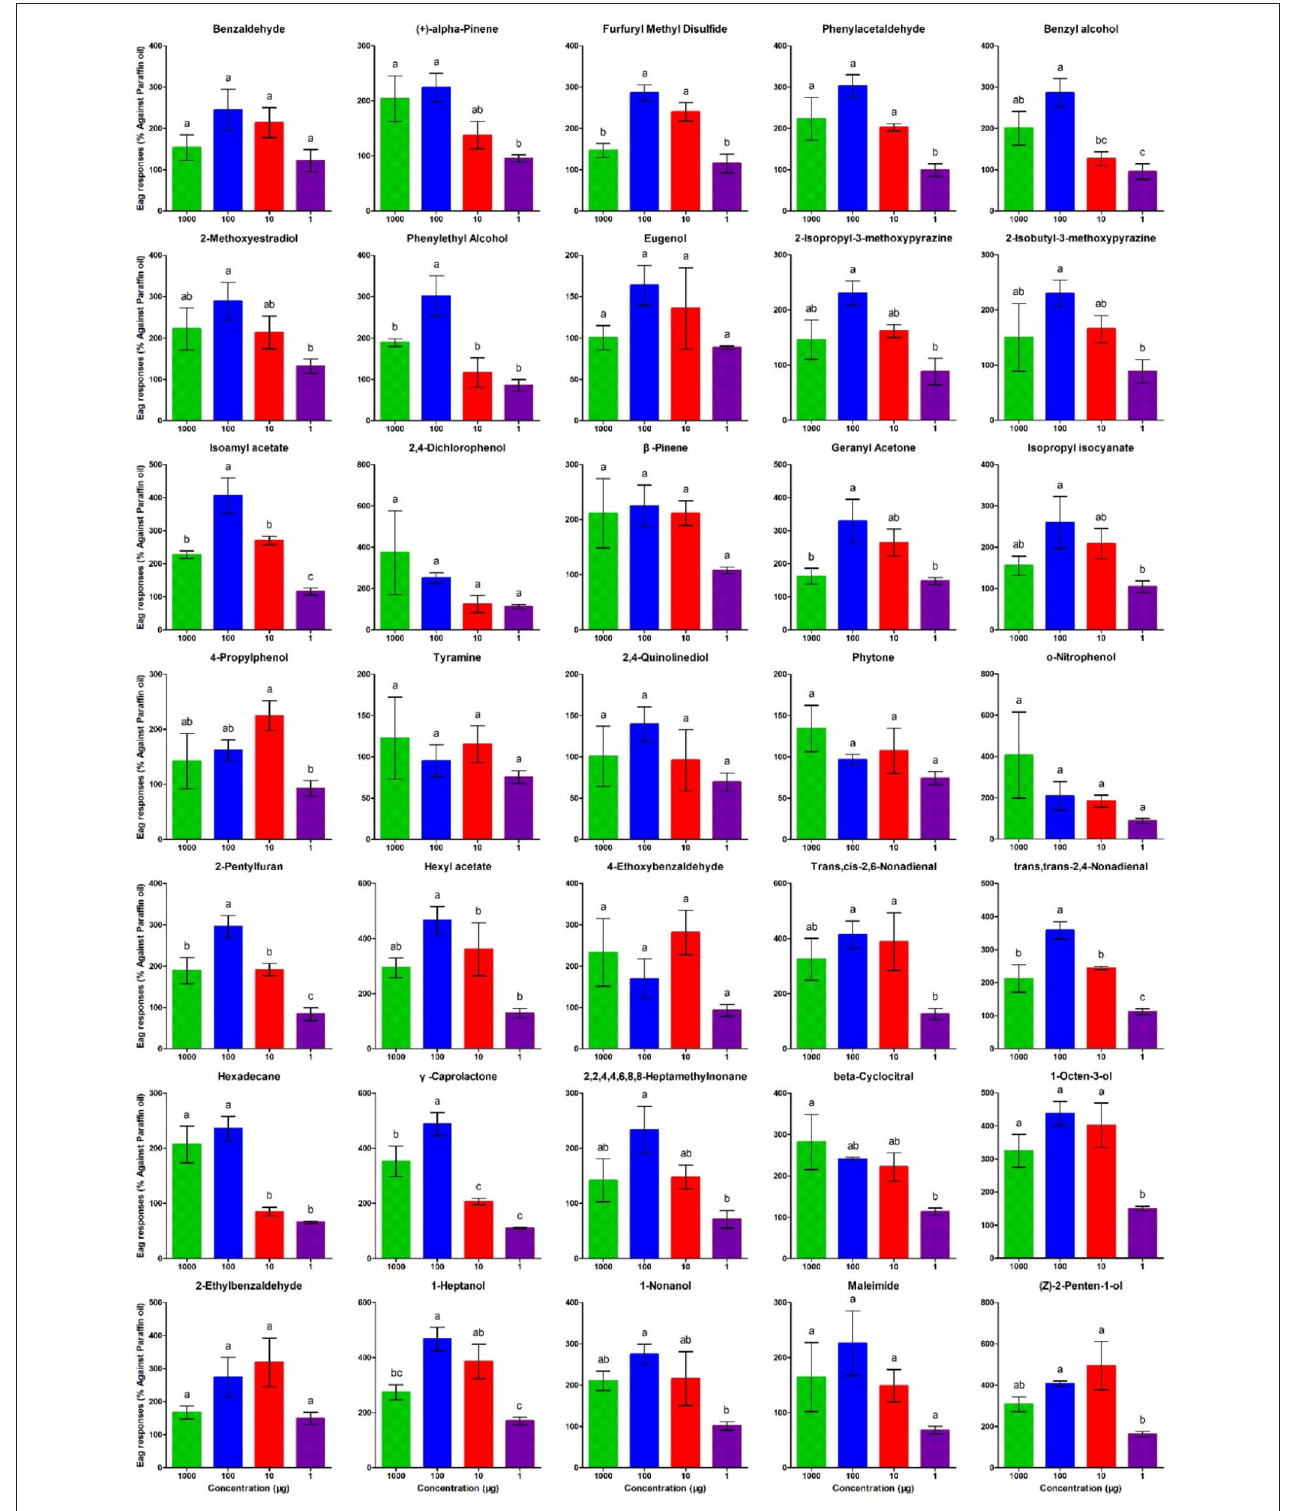
FIGURE 7 | Electroantennographic (EAG) response of T. absoluta females to volatile compounds. The compound names are displayed on top of each chart. The bar represents the mean of the triplicate reading from the EAG experiment. Error bars represent the SEM ( ± SEM). Bars for each compound with a common alphabet displayed on top indicate the significant difference with Turkey’s Highest Significant Difference at P < 0.05.